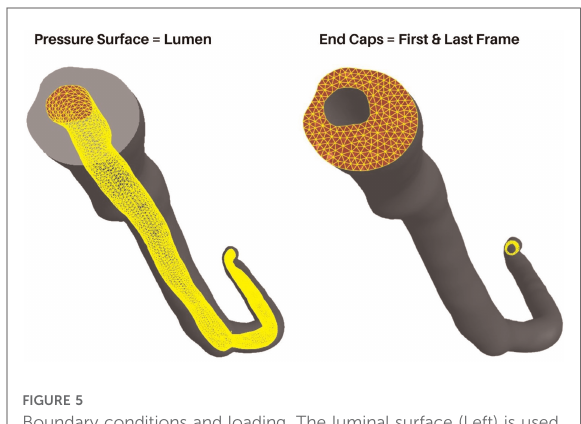
FIGURE 5 Boundary conditions and loading. The luminal surface (Left) is used to apply pressure loads and the end caps (Right) are fi xed in x, y, and z